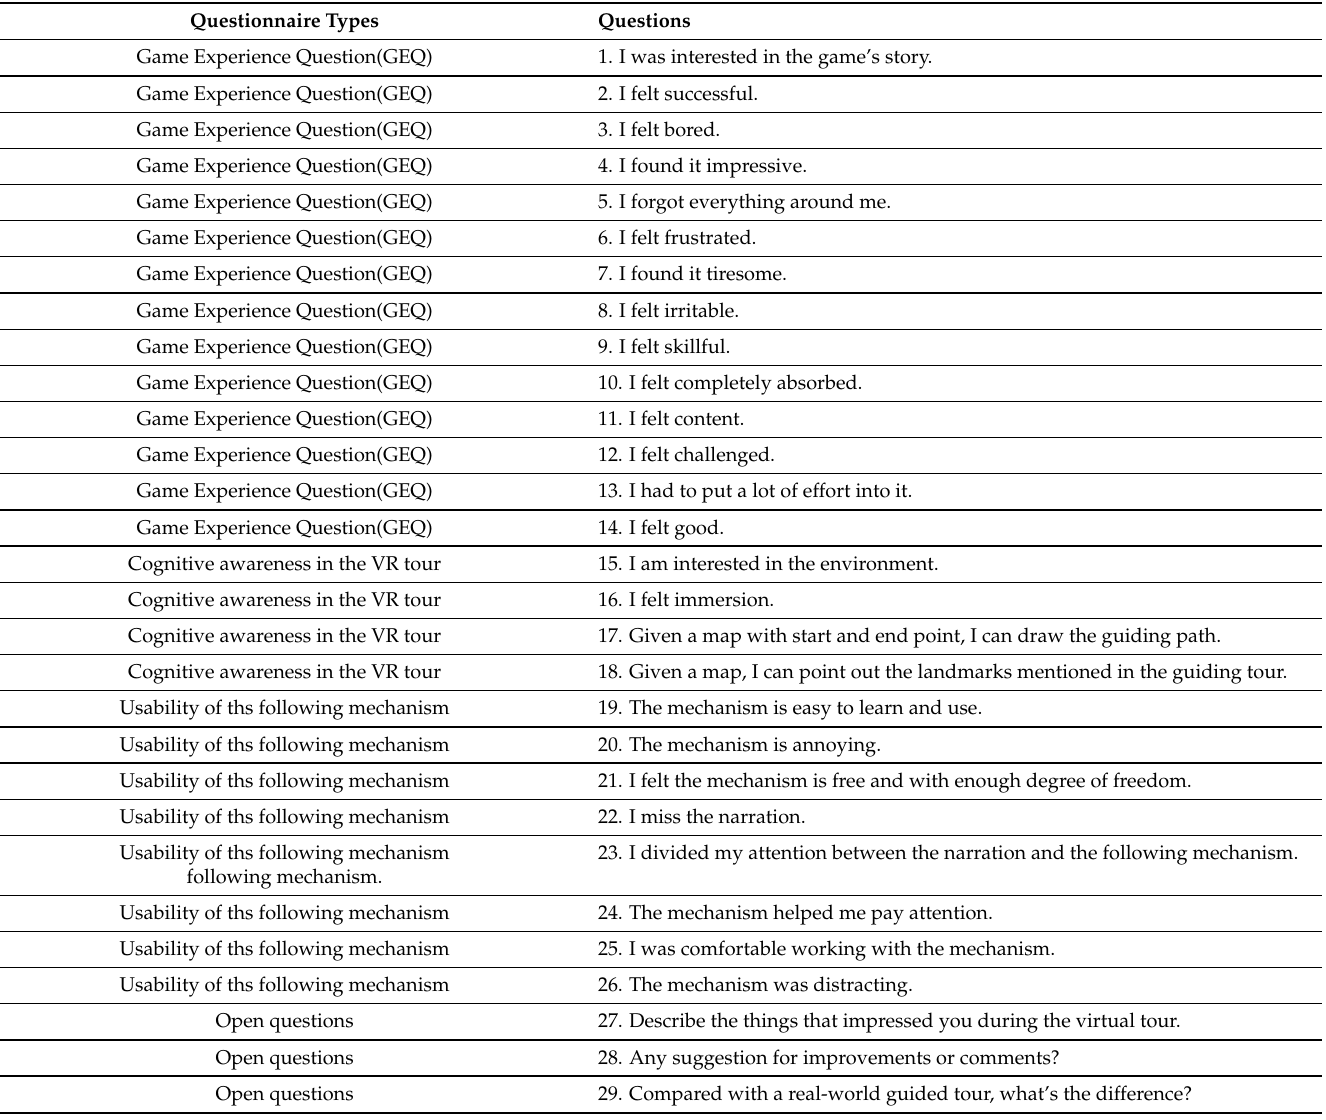
Table 2. The 29 evaluation